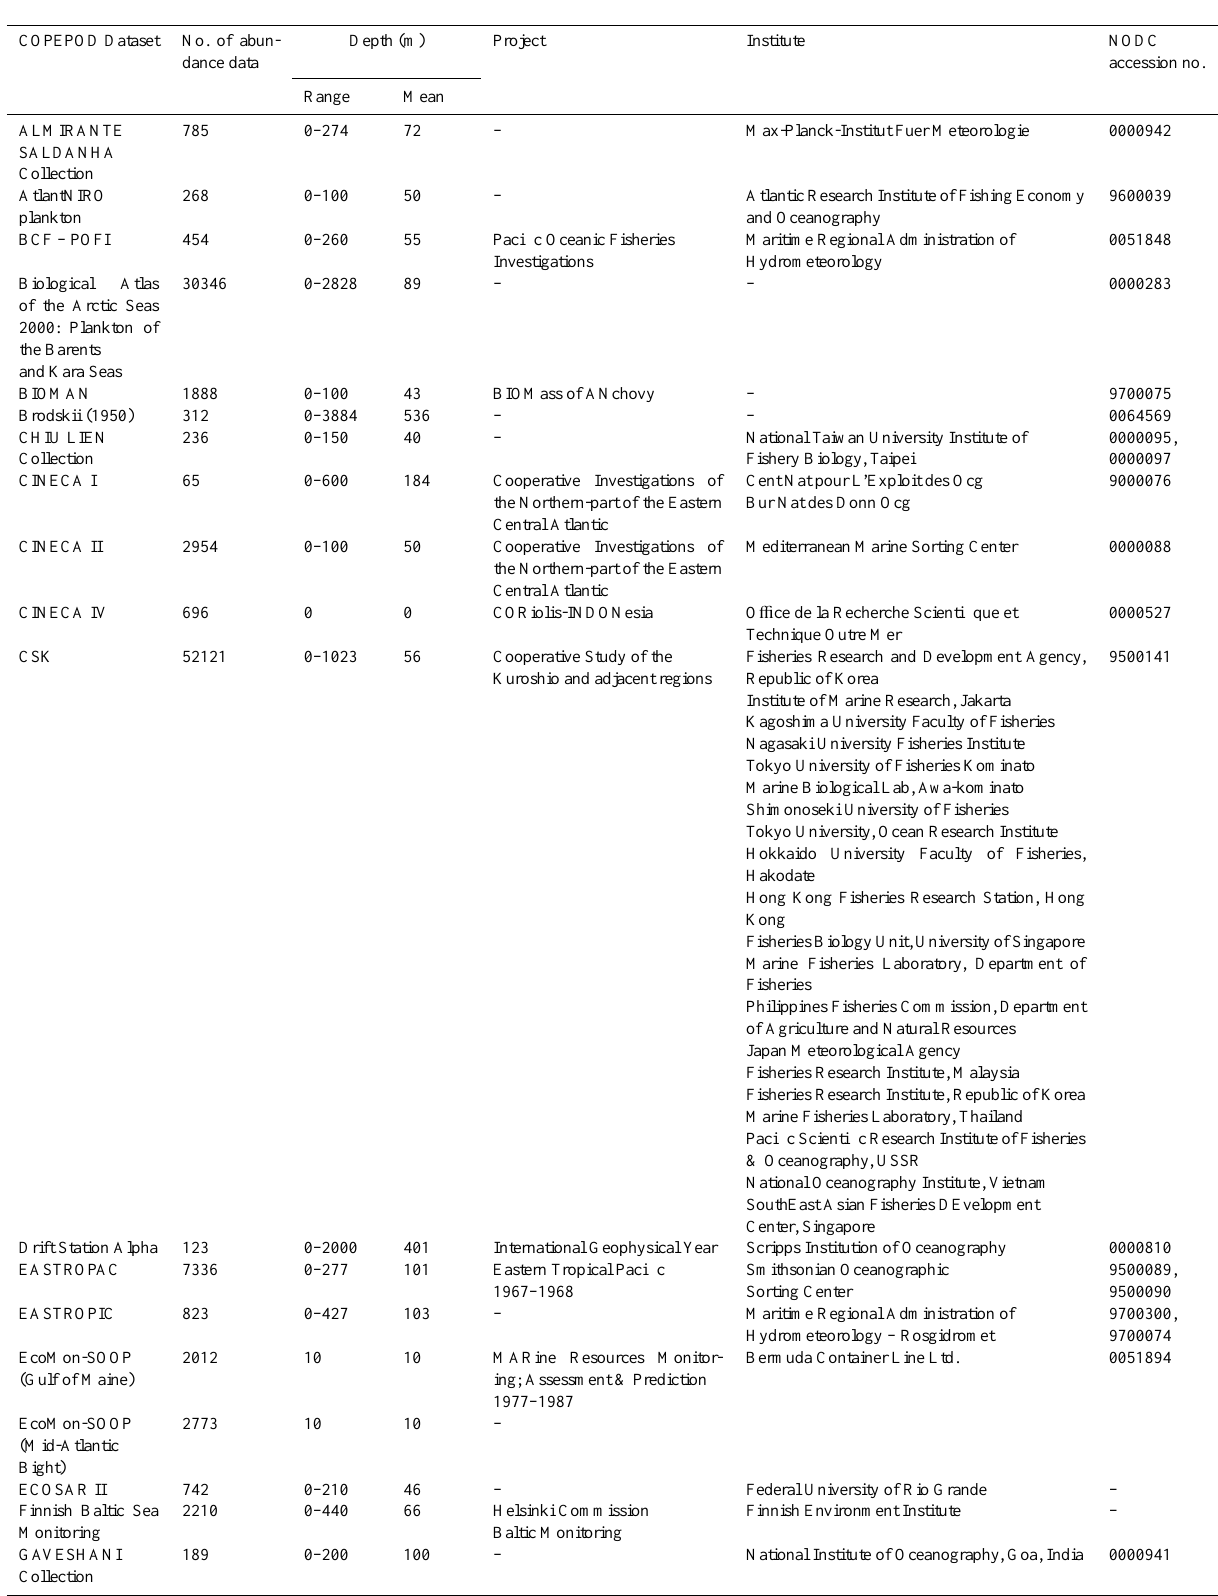
Table 1d. Summary of data points for macrozooplankton abundance from the COPEPOD dataset O’Brien. COPEPOD Dataset No. of abun- dance